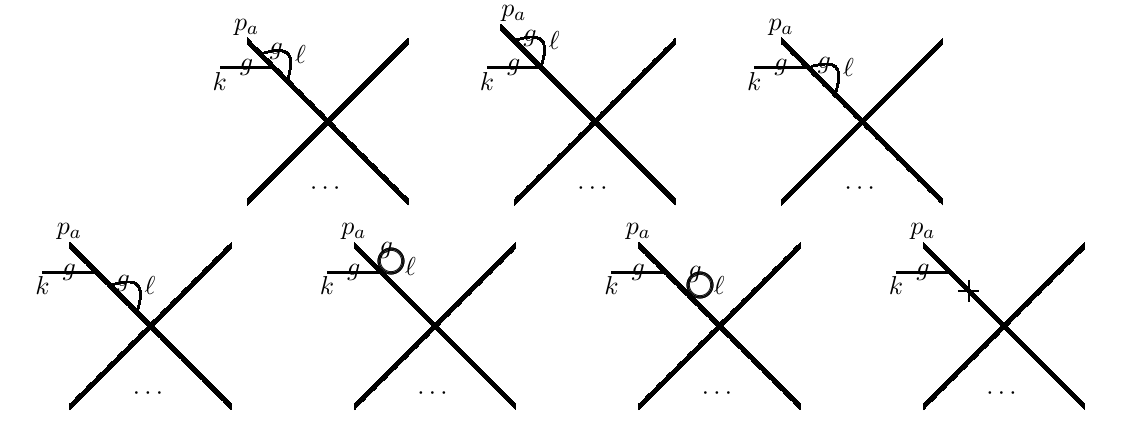
Figure 10 . One loop contribution to (cid:0) ( n; 1) involving internal graviton line connecting two di(cid:11)erent points on the same